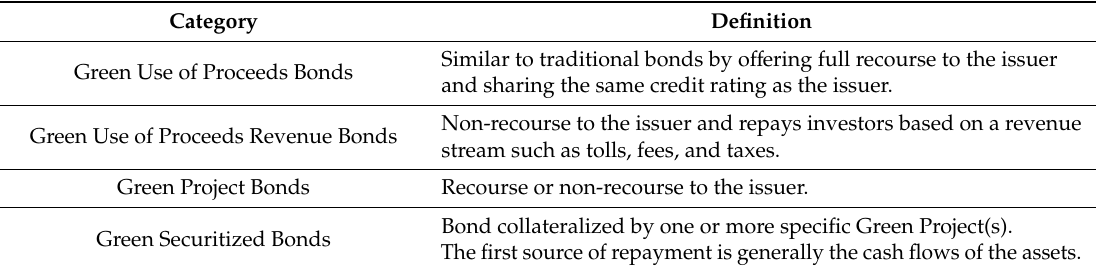
Table 1. Four categories of green bonds (ICMA,